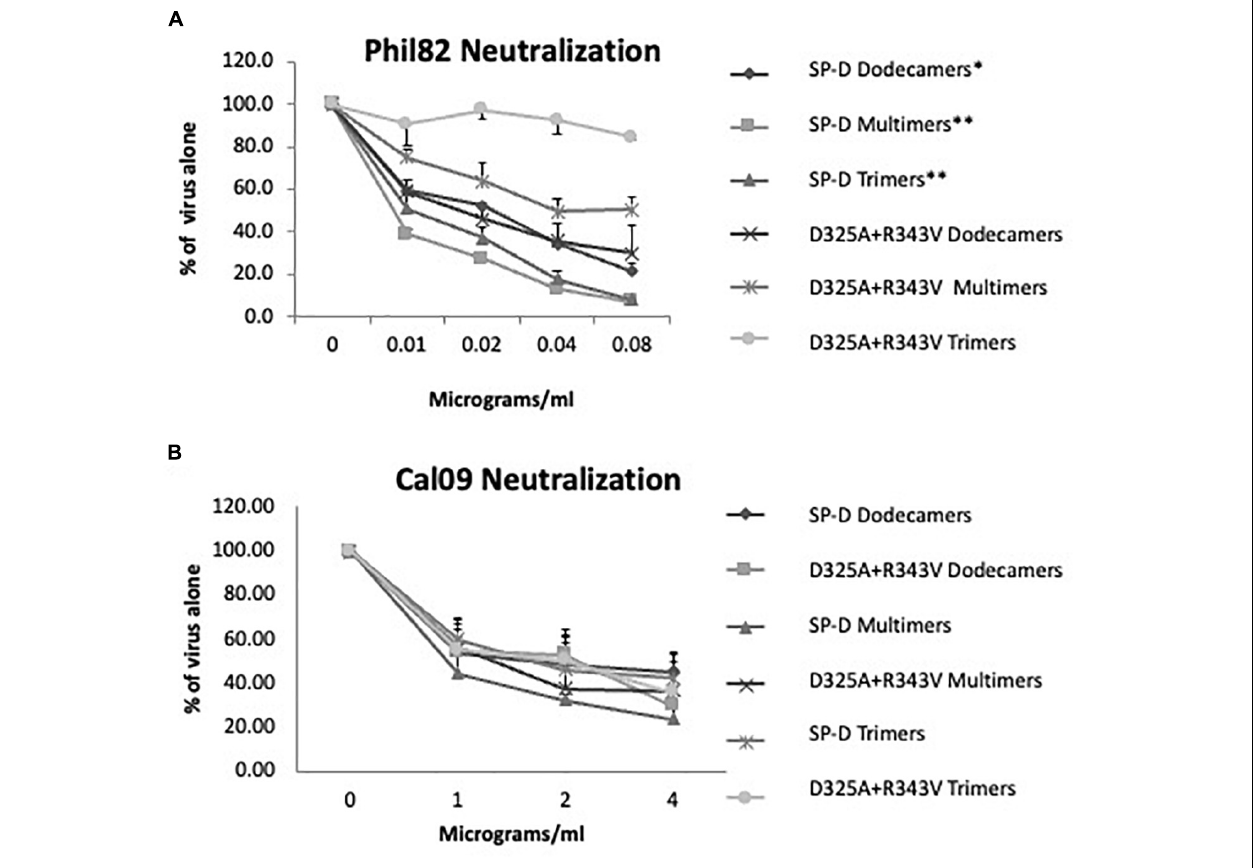
FIGURE 3 | Viral neutralization by full-length wild-type or D325A + R343V molecules. These experiments were performed using the same preparations as in Figure 2 in viral neutralization assays. Neutralization in this and subsequent assays were tested by pre-incubating virus inoculums with the various inhibitory proteins followed by measuring virus titers with the infectious focus assay in vitro (see “Materials and Methods”). Neutralization activity against Phil82 H3N2 is shown in (A) . Instances of significant inhibition compared with control are indicated by ∗ for p < 0.05 and ∗∗ for p < 0.01 (mean ± SEM; n = 4). Neutralization activity against Cal09 is shown in (B) . Note the full-length proteins containing the D325A + R343V mutations caused greater neutralization than wild-type SP-D molecules.